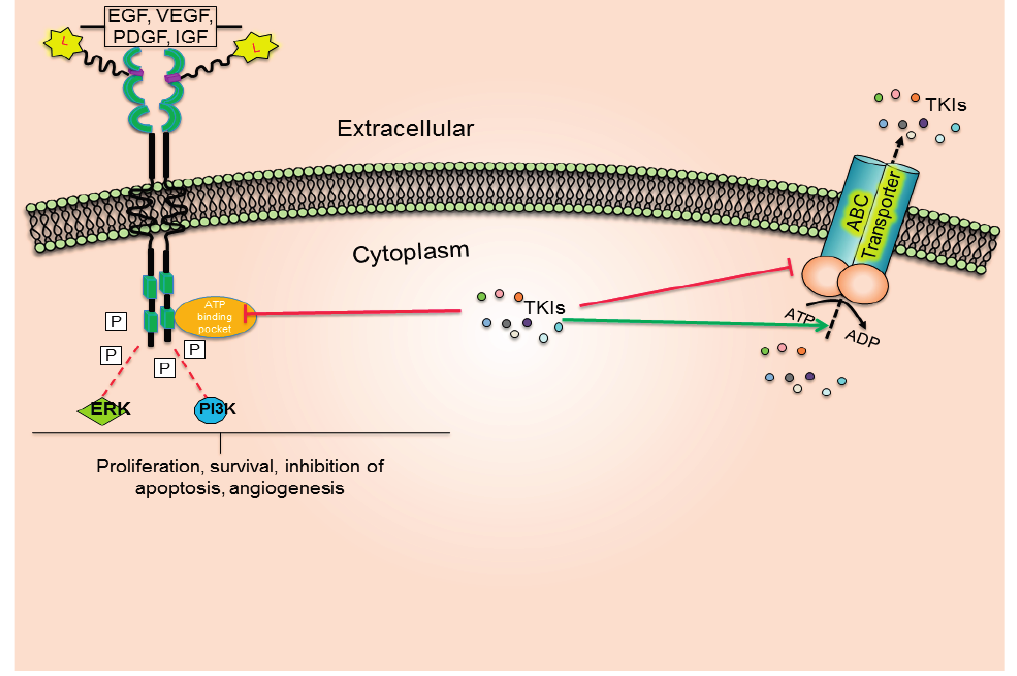
Figure 2. Schematic representation of TKI interaction with TK and ABC drug